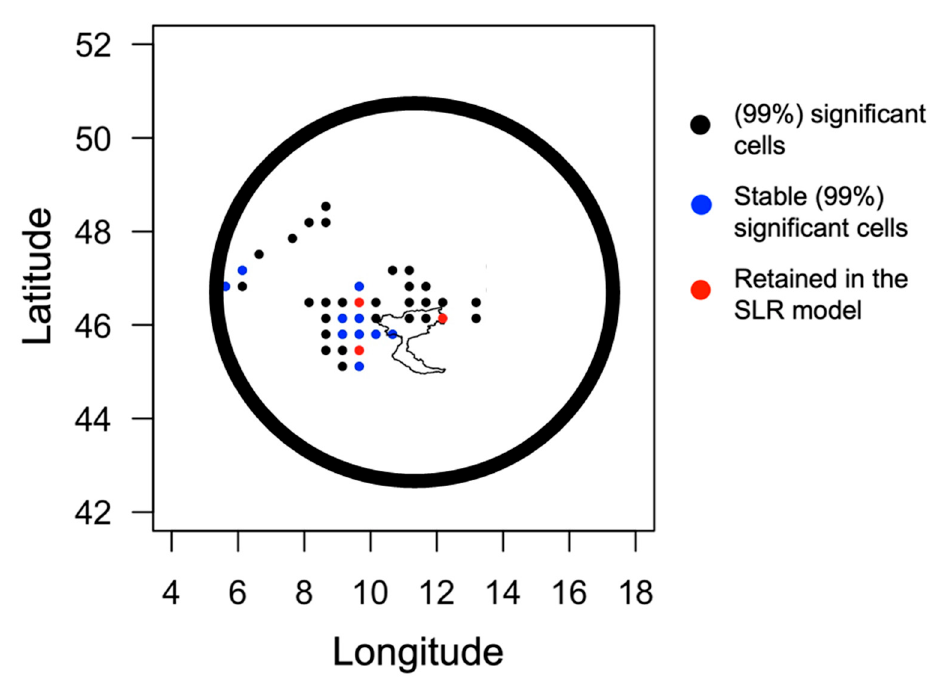
Figure 7. The circular black line represents the 450 km search radius while the Adige River Basin watershed is provided. The three red circles represent scPDSI cells retained in the SLR model; the ten blue circles represent scPDSI stable cells that were not retained in the SLR model; and the twenty-seven black circles represent significant (99%) cells that were not stable.